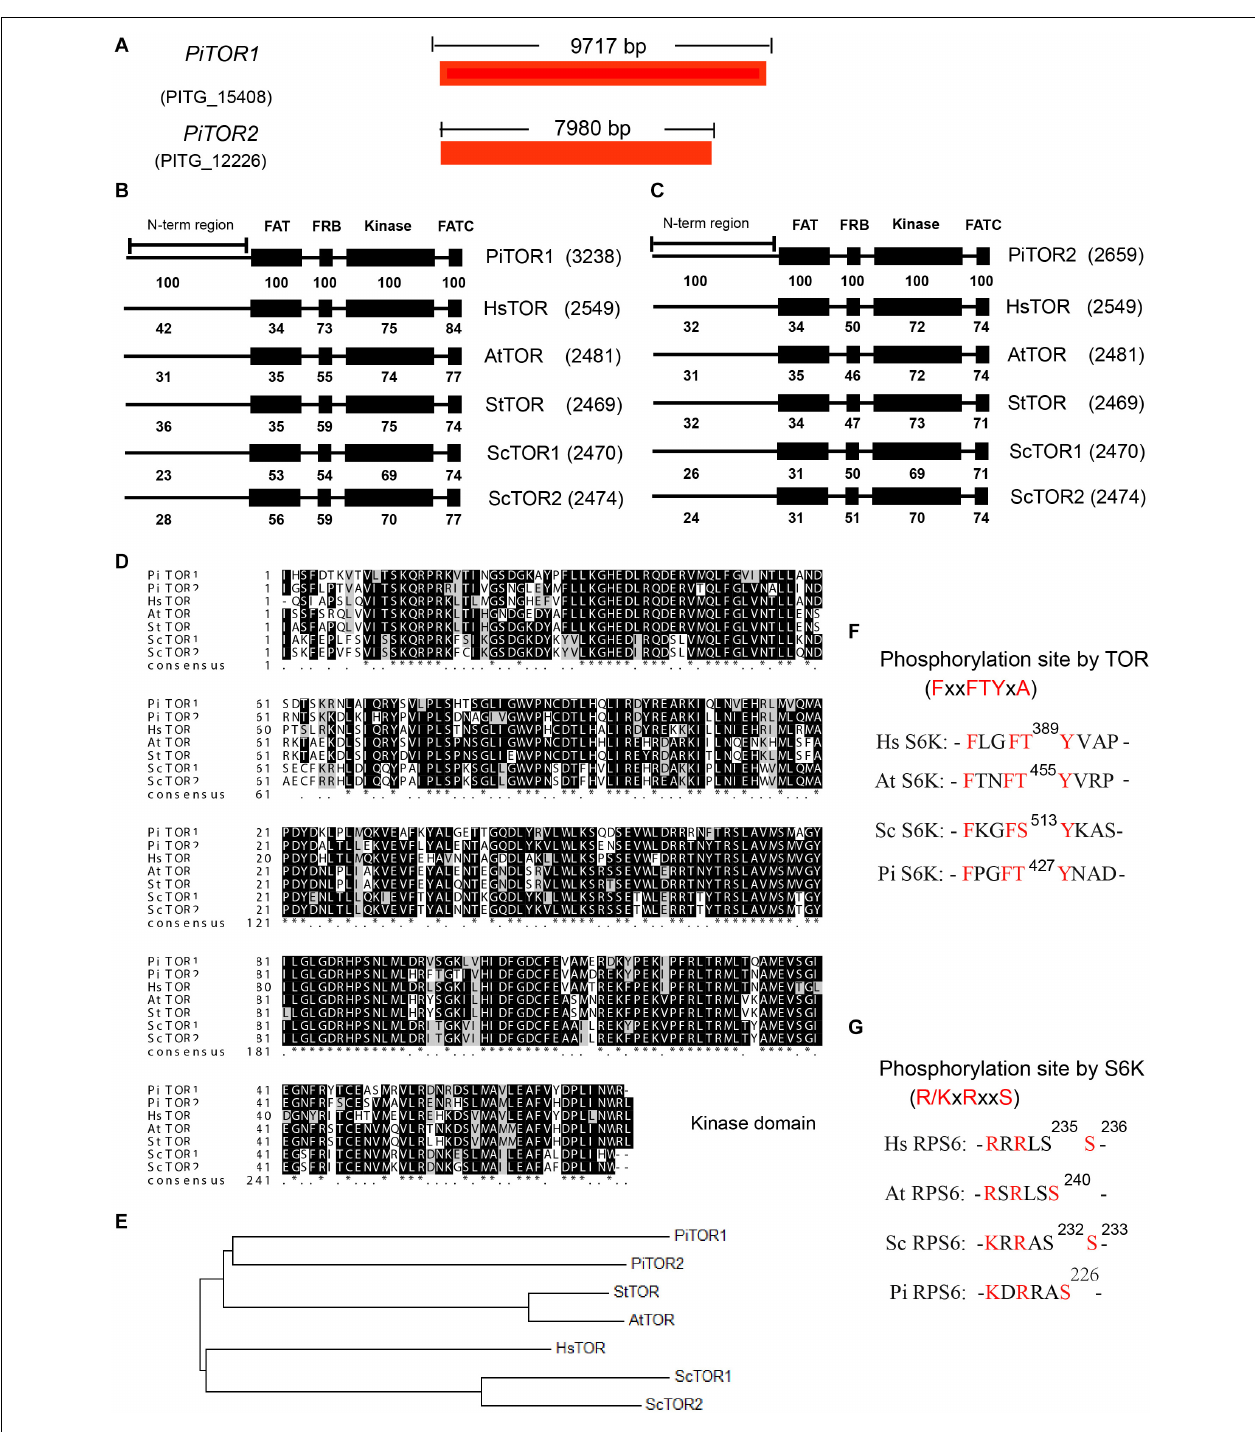
FIGURE 1 | Sequence and structure analysis of the PiTOR gene in P. infestans . (A) Gene length of PiTOR1 and PiTOR2 in P. infestans . PiTOR1 and PiTOR2 are the homologous proteins of TORs in P. infestans . Red represents exons. No intron existed in PiTOR. (B,C) Comparison of four main TOR domains (FAT, FRB, kinase, and FATC) in Pi, Hs, At, St, and Sc. (D) Comparison of kinase domain in Pi, Hs, Sc, At, and St. (E) Evolutionary relationship of homologies of TORs in Pi, Sc, St, At, and Hs. The neighbor-joining method of MEGA5.0 was used to analyze the evolutionary relationship. (F,G) Comparison of phosphosite and conserved motif of S6Ks and RPS6s in Pi, Sc, At, and Hs (Pi, Phytophthora infestans ; Hs, Homo sapiens ; Sc, Saccharomyces cerevisiae ; At, Arabidopsis thaliana ; St, Solanum tuberosum ).